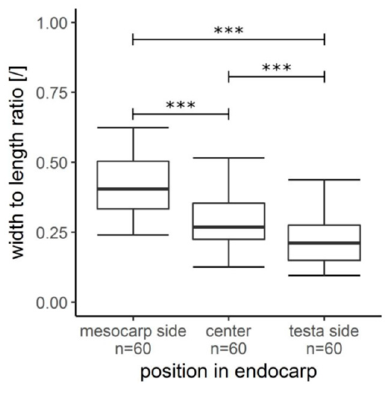
Figure 4. LM images from the coconut endocarp showing sclereids. The cross section of a polished thin section shows a longitudinally cut vascular bundle within the brown tissue of the sclereid cells ( A ). Higher magnifications of the sclereid cell matrix reveal larger cells near the mesocarp side ( B ) than near the testa ( C ). Very long sclereids, the sclerenchyma fibers, are located in parallel to the vascular bundles ( D ). Macerated endocarp cells stained with Toluidin blue, showing sclereid cells with various shapes ( E ).